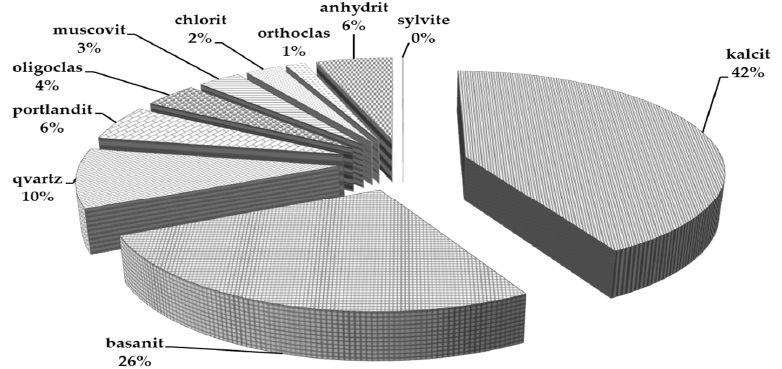
Figure 7. Mineralogical composition of waste water sludge from a concrete plant.